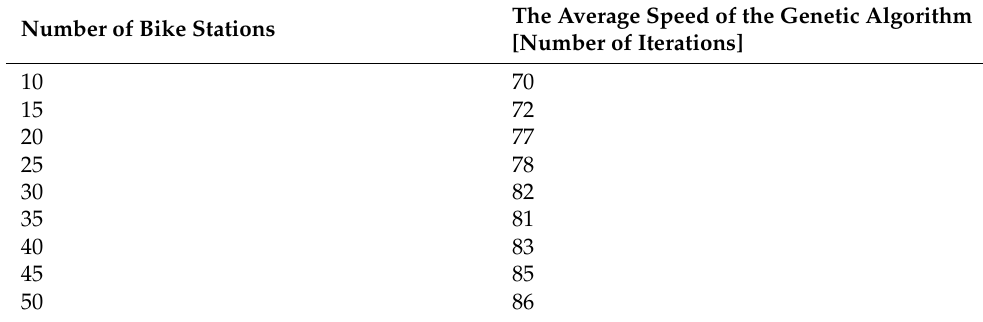
Table 5. The average speed of the genetic algorithm for different cluster sizes. The Average Speed of the Genetic Number of Bike Stations